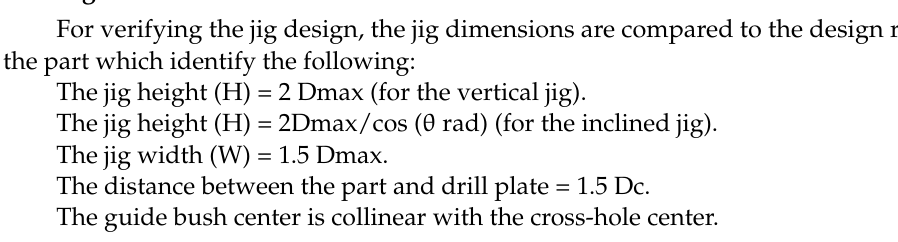
Figure 58. The jig views.